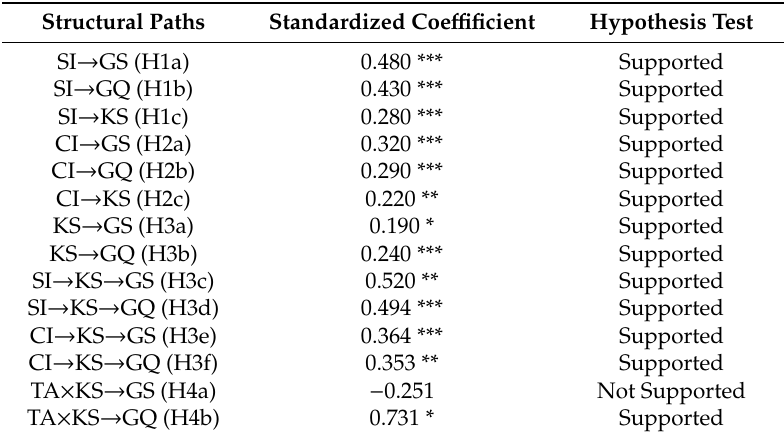
Table 9. Results of H1a-H4b